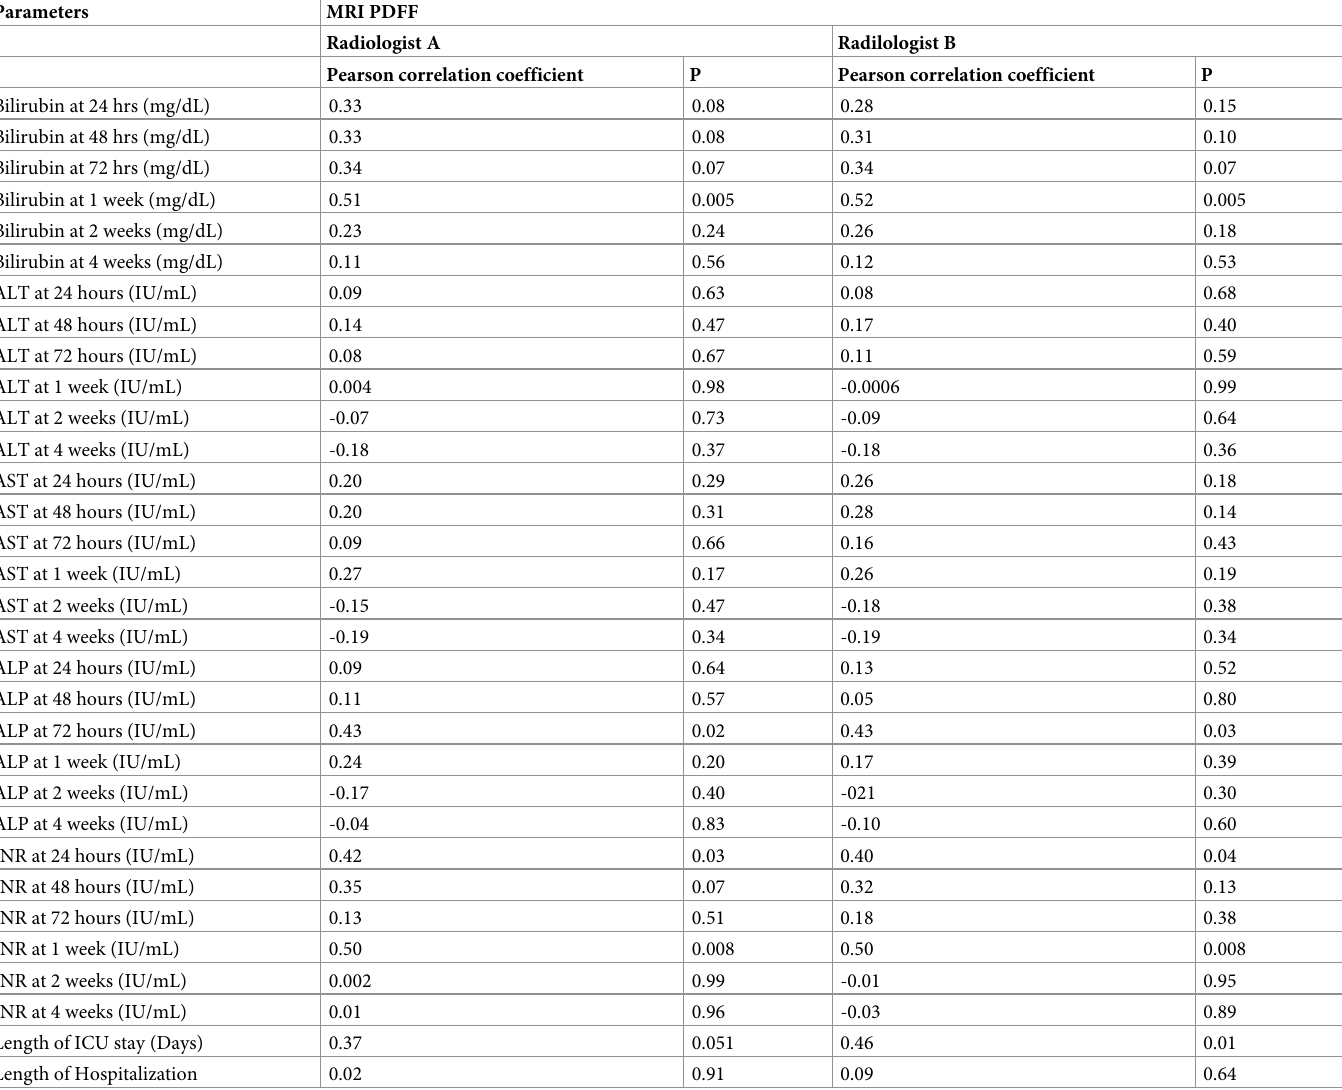
Table 5. Correlations of early post-transplant liver chemistry, and clinical outcomes based on hepatic fat quantification by MRI PDFF.